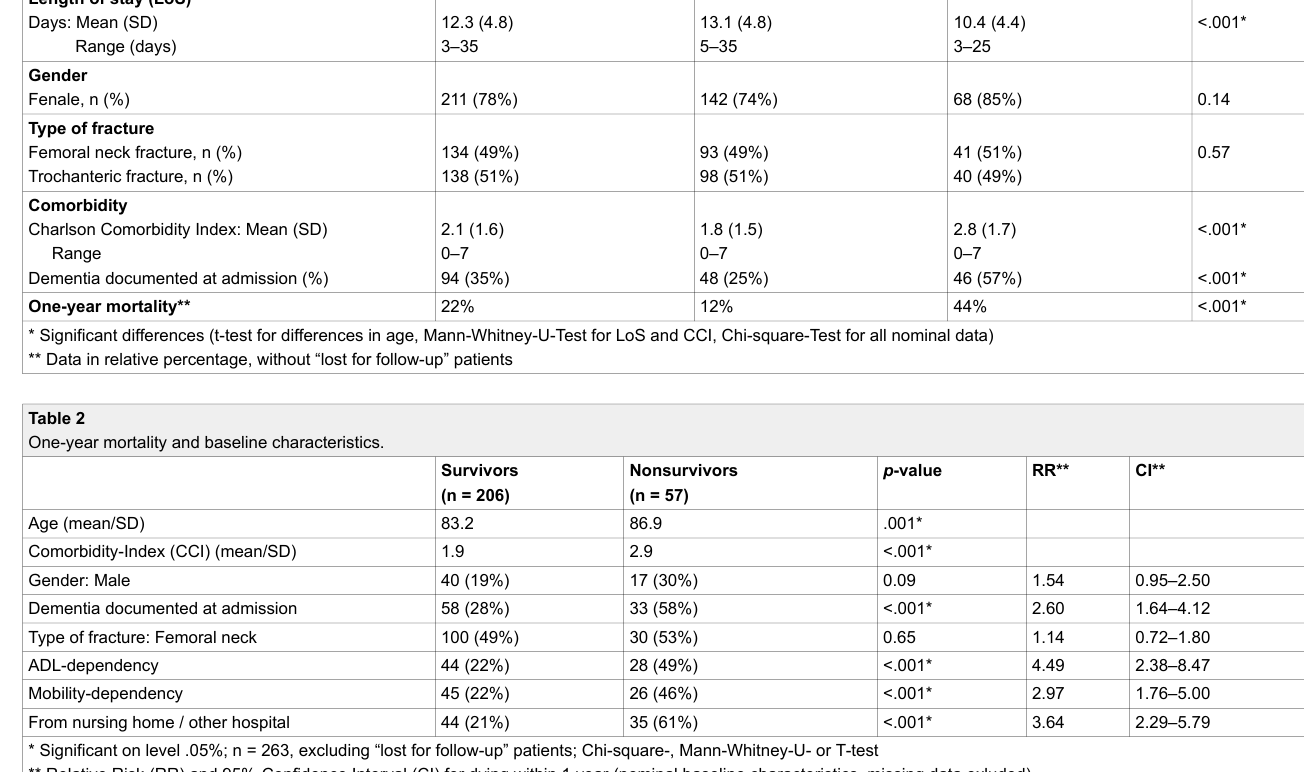
Overall sample: Patients ≥65 with Hip Fractures (n = 272 = 100%)